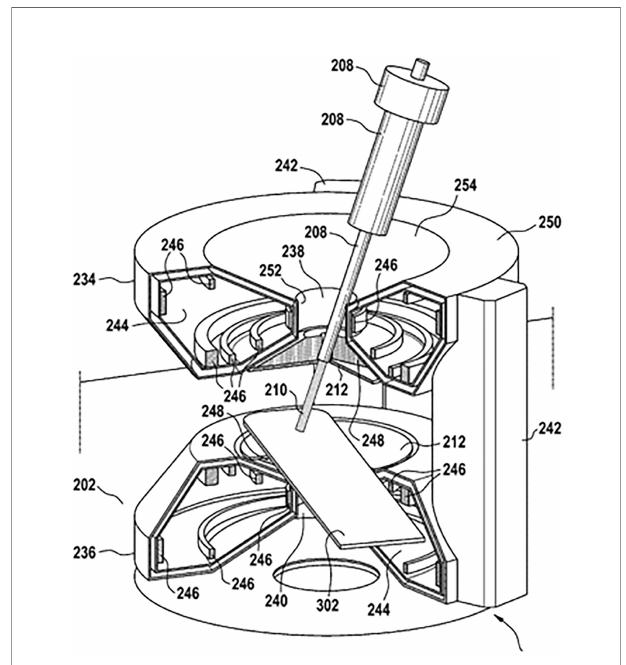
FIGURE 6 | Possible con fi guration of a hybrid MRI proton system, taken from patent application US 10 , 173 , 077 B2 (45). Date of Patent: Jan. 8, 2019